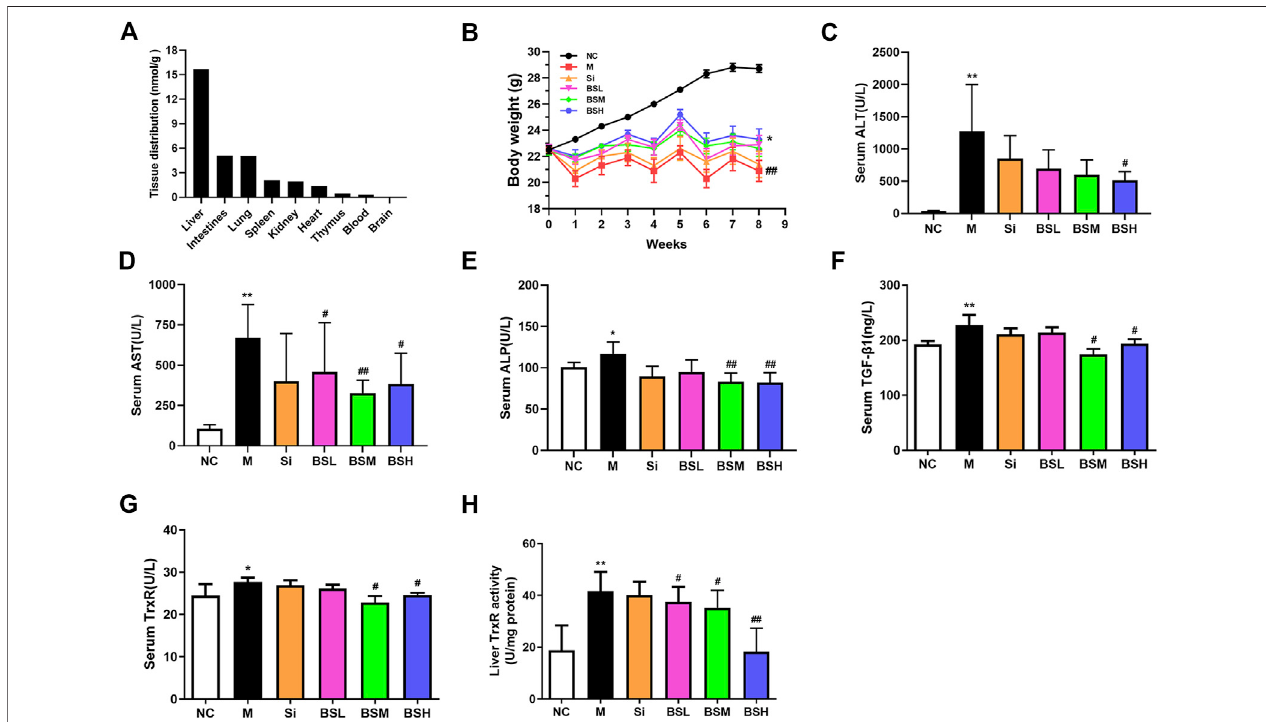
FIGURE5| BSamelioratedthebiomarkersofCCl 4 -inducedliver fi brosisinmice. (A) TissuedistributionsofBS(180 mg/kg)for21 dayswereanalyzed. (B) Bodyweightchanges. (C – E) Liver function was assessed by serum ALT, AST, and ALP. (F) Serum TGF- β 1 levels. (G – H) The liver and serum TrxR levels were analyzed by ELISA. Data were shown as mean ± SD, n ≥ 3 and analyzed with the one-way ANOVA. * p < 0.05 and ** p < 0.01 in the model group versus the control group. # p < 0.05, ## p < 0.01, Si, BSL, BSM, and BSH groups versus the model